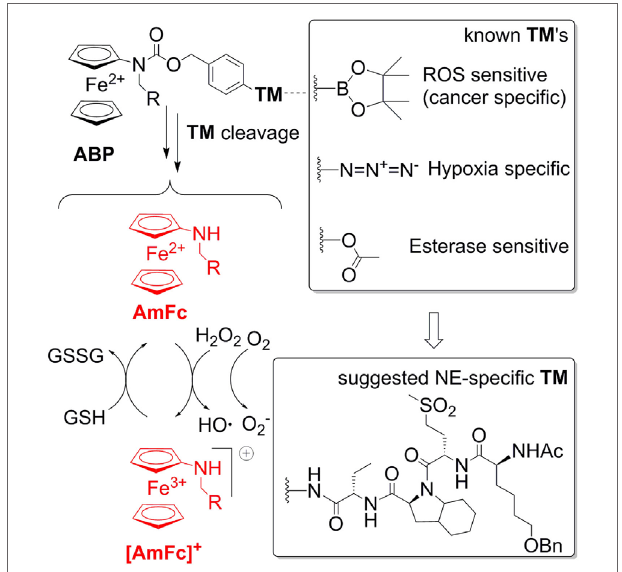
FigURe 4 | A general structure of aminoferrocene-based prodrugs (ABPs) and the mechanisms of their activation after cleavage of the triggering moiety (TM). The NE-sepcific TM is based on the peptide reported in Ref.